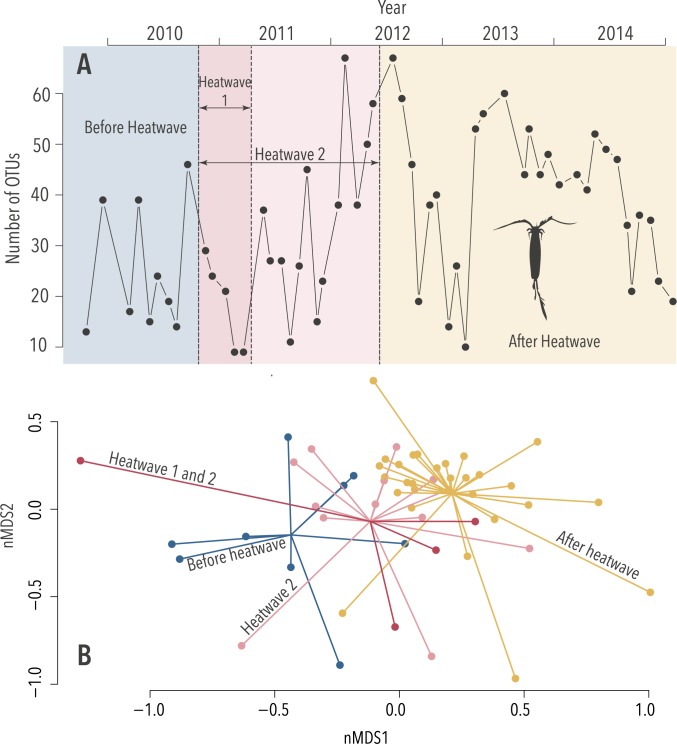
Heatwave effects revealed by Copepod 1 eDNA assay “Heatwave 1” and “Heatwave 2” are indicated.(A) Changes in the number of Operational Taxonomic Units (OTUs) over time (Richness: Heatwave 1; p < 0.01 & Heatwave 2; p < 0.05) and (B) changes in the diversity of the OTUs revealed by non-parametric multivariate analysis (Assemblage; k = 3, stress = 0.15, both p < 0.001), the coloured lines extrude from the centroids of each time period towards the variation in Assemblage from each sample.